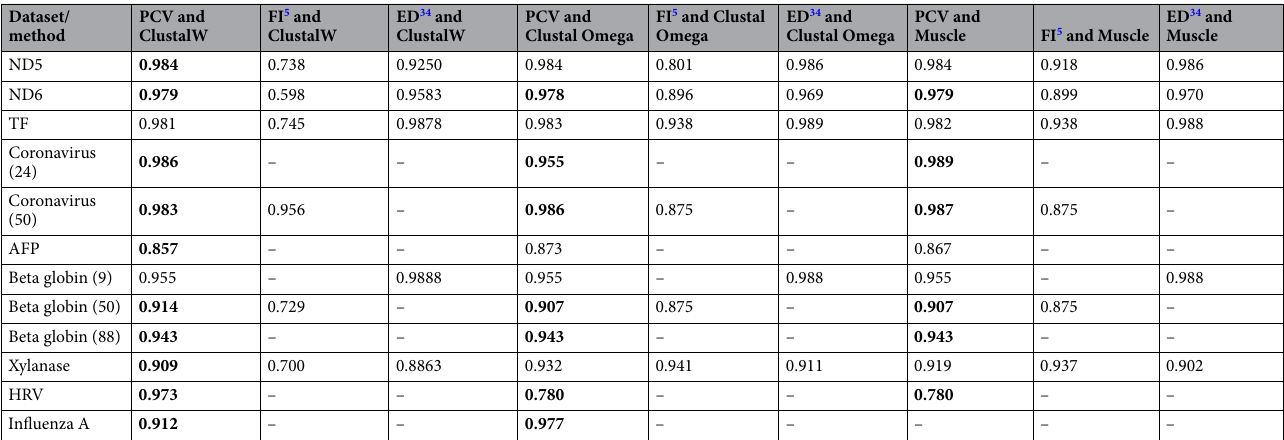
Table 4. Comparison of PCV, Fuzzy integral based method, and ED method based on Correlation Coefficient (CC) distance with ClustalW, Clustal Omega, and Muscle for 12 benchmark datasets. Significant values are in